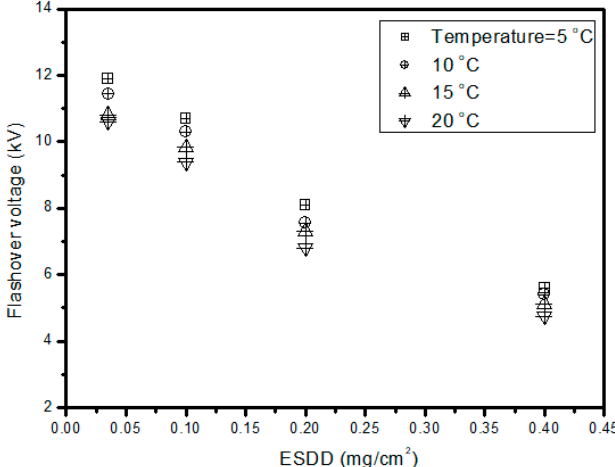
Figure 5. The relationship between ambient temperature and critical flashover voltage at moderate humidity and NSDD of 0.75 mg/cm 2 .